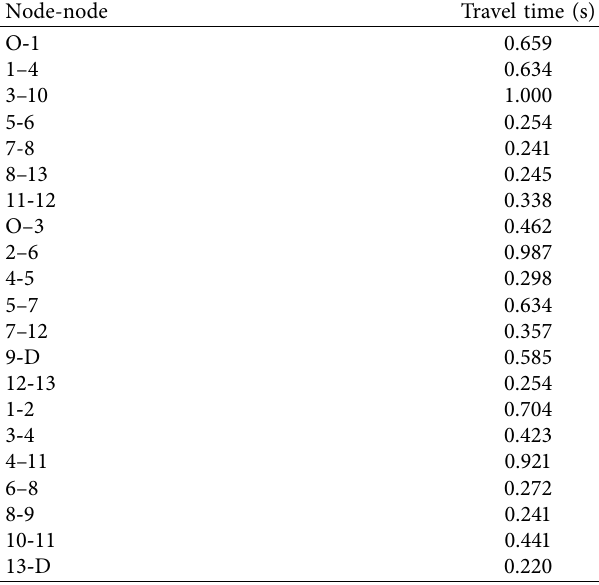
Table 6: Table of travel time at a certain time.